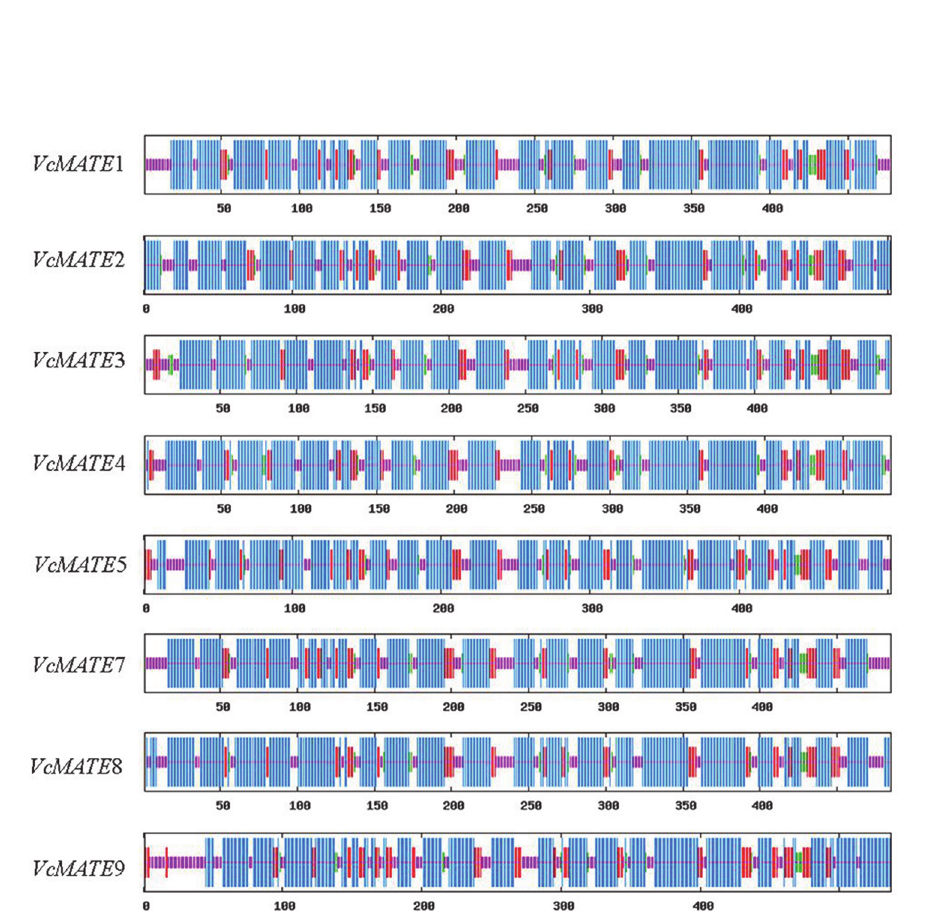
Fig 1. Secondary structures of the 8 blueberry MATE proteins predicted by SOPMA. The α -helix, extended strand, β -turn, and random coil are denoted as the longest (blue), medium long (dark red), short (green), and the shortest (pink) vertical bars,